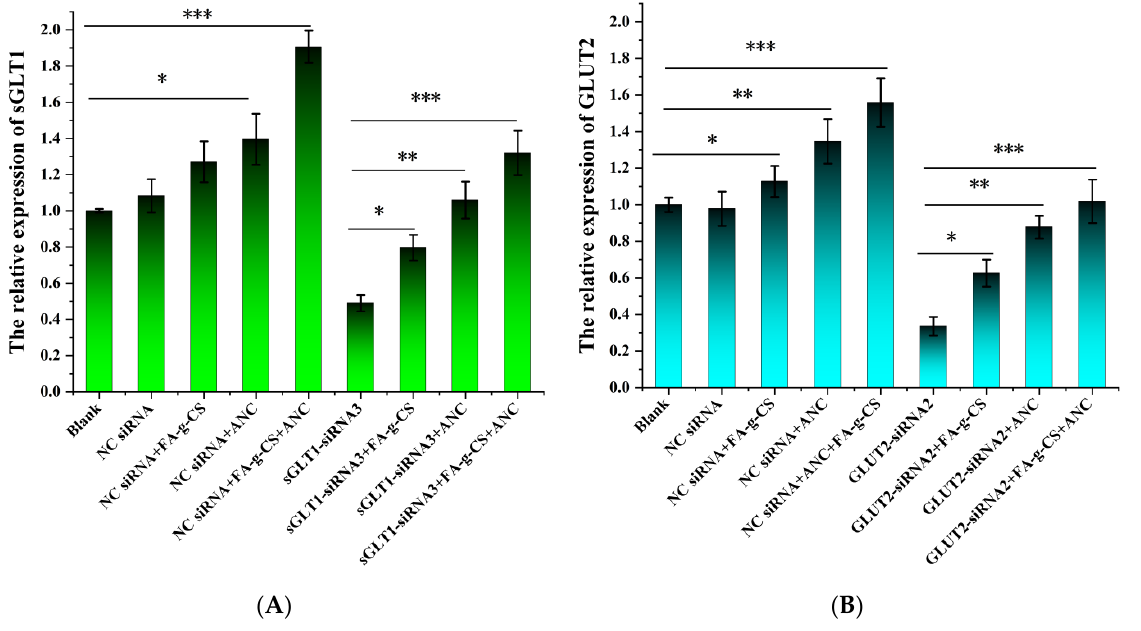
Figure 3. Expression of sGLT1 and GLUT2 in Caco-2 cells incubated with FA-g-CS, ANC, or their combination after siRNA transfection, as determined by Western blotting ( A , B ). *— p < 0.05 versus control; **— p < 0.01 versus control; ***— p < 0.001 versus control.